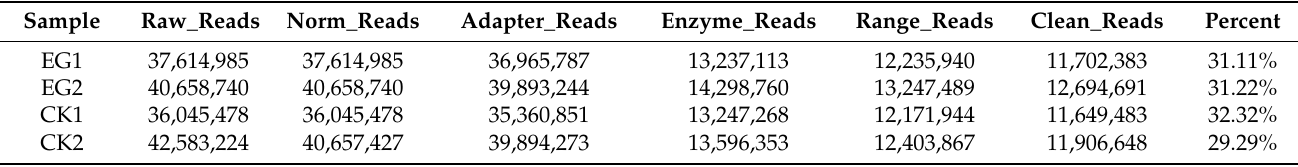
Table 1. Statistics table for data volume changes.